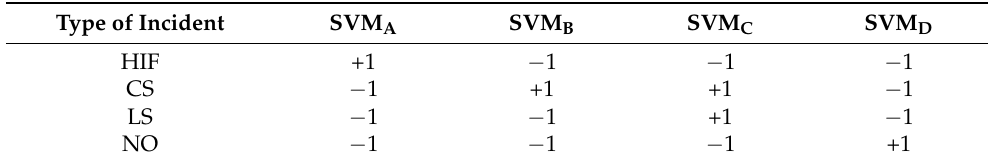
Table 3. SVM classification matrix.